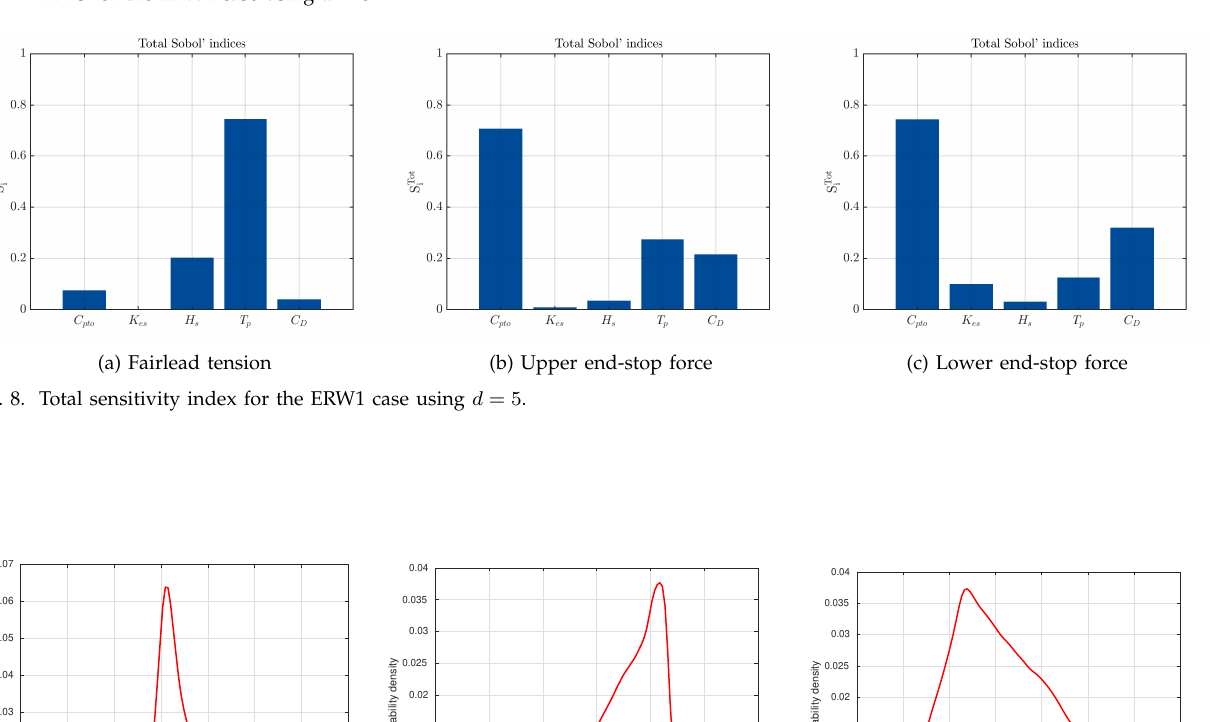
Fig. 7. PDFs for the ERW1 case using d = 5 .